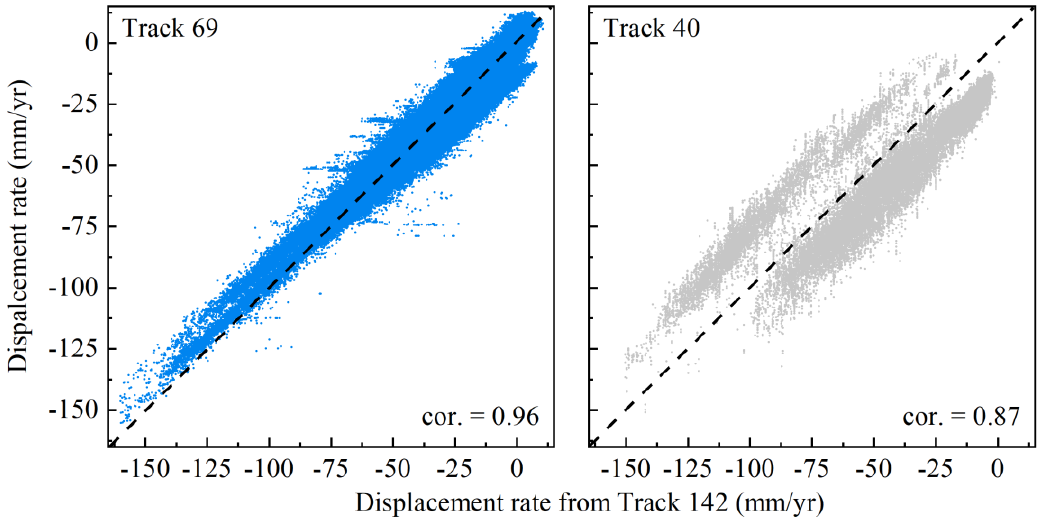
Figure 8. Consistency between the vertical displacement rates derived from different datasets: the vertical displacement rate from track 142 is chosen as a reference.